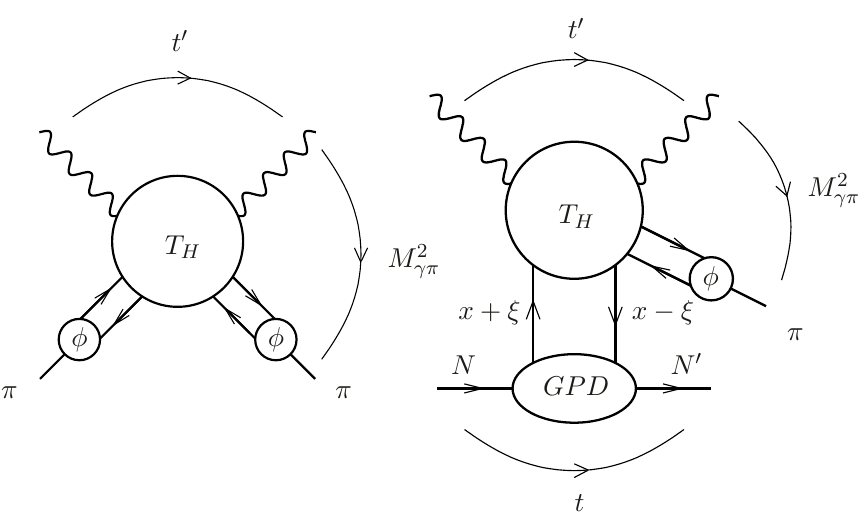
Figure 1 . Left: factorization of the amplitude for the process γ + π γ + π at large s and fixed → angle (i.e. fixed ratio t ′ /s ). Right: replacing one DA by a GPD leads to the factorization of the amplitude for γ + N γ + π + N ′ at large M 2 γπ →